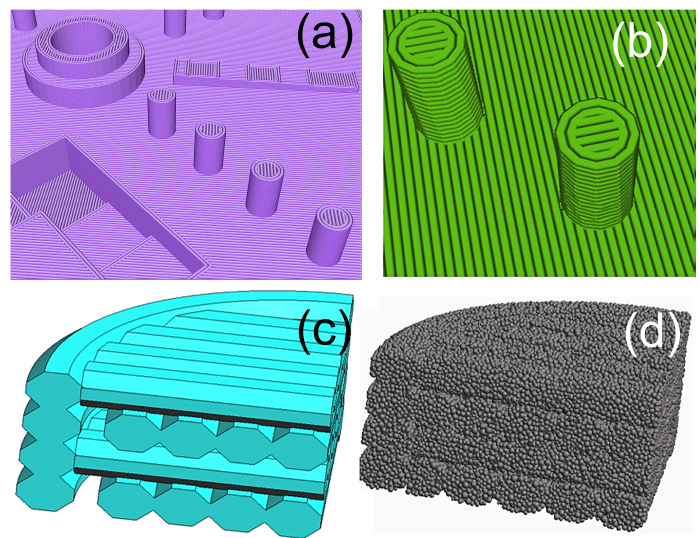
Figure 8. ( a ) Fragment of sliced NIST artefact for additive manufacturing. ( b ) Zoomed view of a small part of the artefact. ( c ) Geometry of the top few layers of the cylinder shown in figure ( b ) obtained in KRATOS DEM. ( d ) Discrete element model of the filaments in KRATOS DEM. The total number of spherical particles in the model ≈ 150,000.